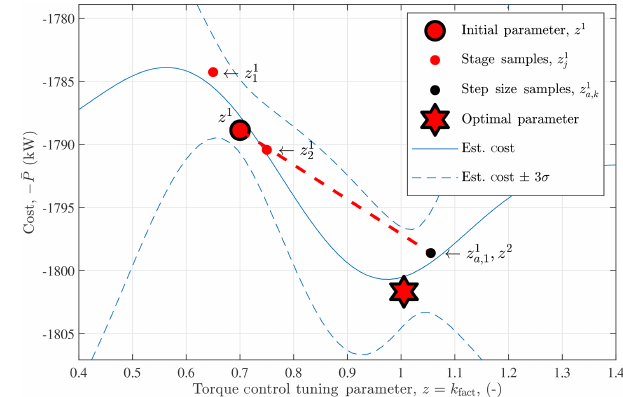
Figure 1. The first iteration of the one-dimensional parameter tun- ing for the optimal torque control gain. Starting with the initial pa- rameter z 1 , random samples z 1 and z 1 are generated to estimate the 1 2 gradient. The test sample z 1 is evaluated in the gradient direction a, 1 until the cost decreases and the next stage parameter z 2 is deter- mined. The estimated cost and uncertainty shown are determined af- ter r = 1 stage (four parameters and 12 total simulations) and found (cid:113) using Eqs. (13) and (19), respectively, where σ ( z ) = MSE [ ˆ C ( z ) ]